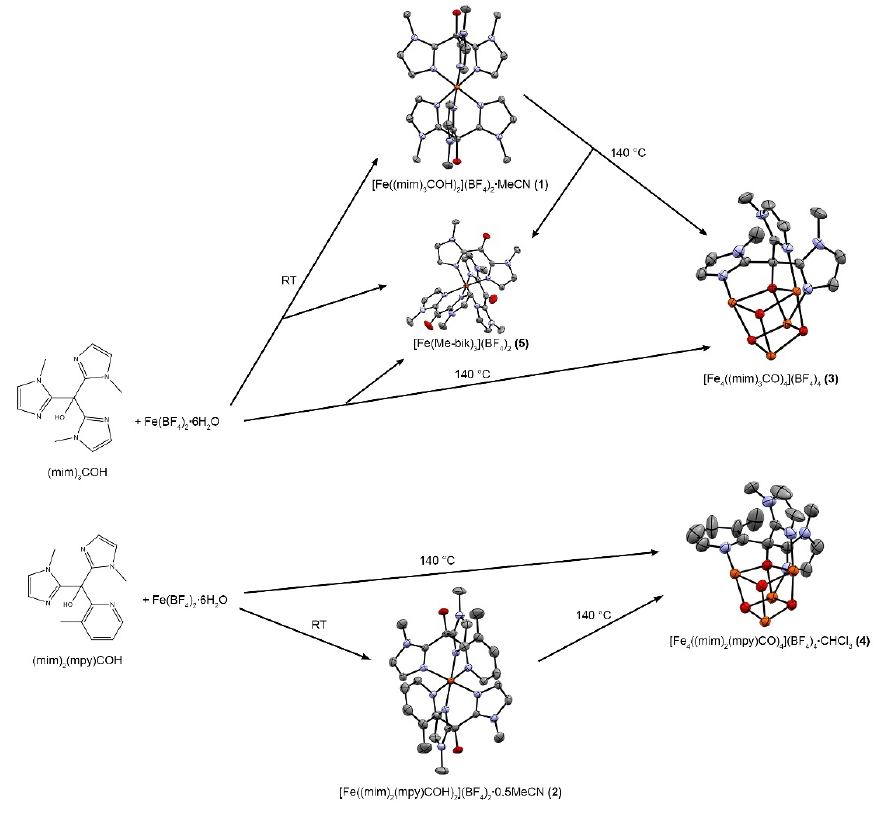
Figure 1. Reaction scheme for the cluster formation, with hydrogens, anions, and solvates omitted. ( top ) (mim) 3 COH coordinates Fe(BF 4 ) 2 ∙6H 2 O, resulting in the octahedral complex 1 and the rear- ranged elimination product 5 . Solvothermal reaction of ligand and Fe(II) or solvothermal treatment of 1 yield [Fe 4 O 4 ]-cluster 3 with 5 as a competing path. ( bottom ) (mim) 2 (mpy)COH coordinates Fe(BF 4 ) 2 ∙6H 2 O resulting in the octahedral complex 2 . Solvothermal reaction of ligand and Fe(II) or solvothermal treatment of 2 yields [Fe 4 O 4 ]-cluster 4 .